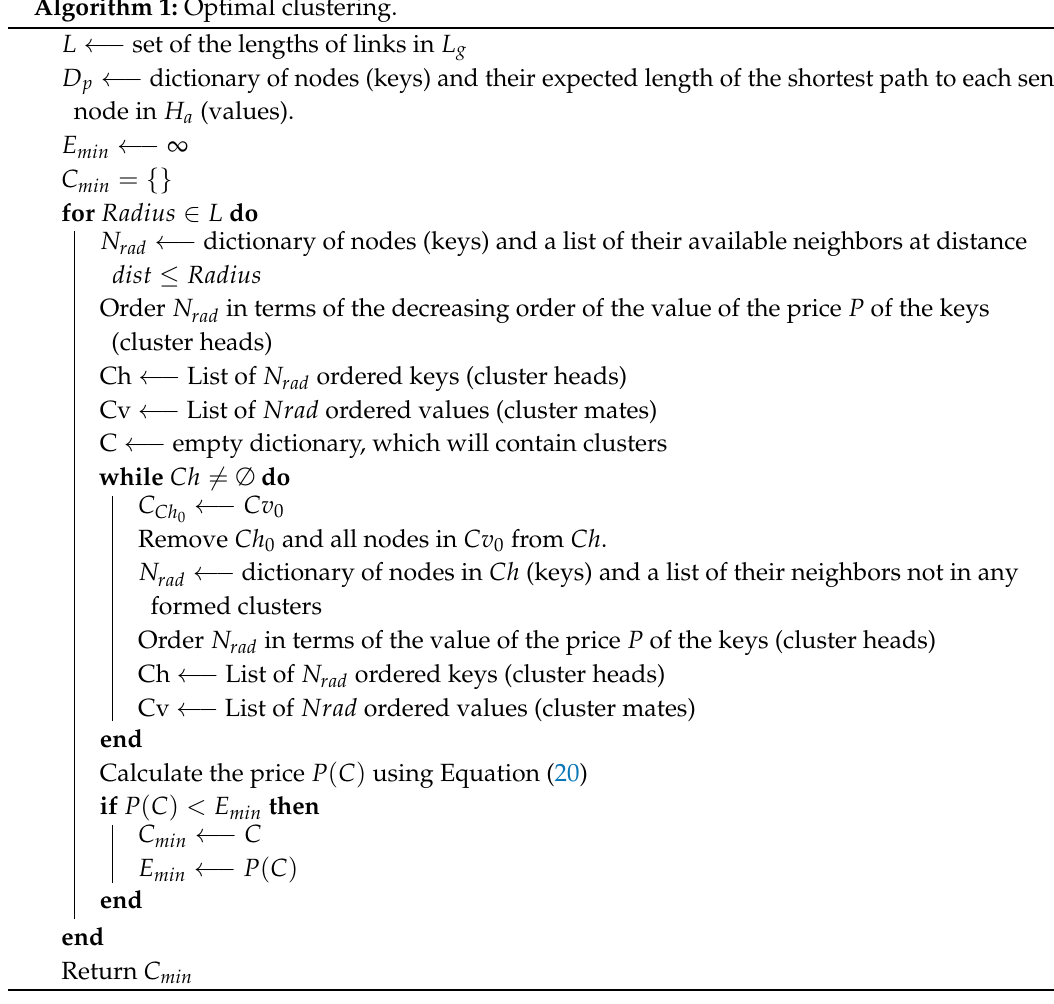
Algorithm 1: Optimal